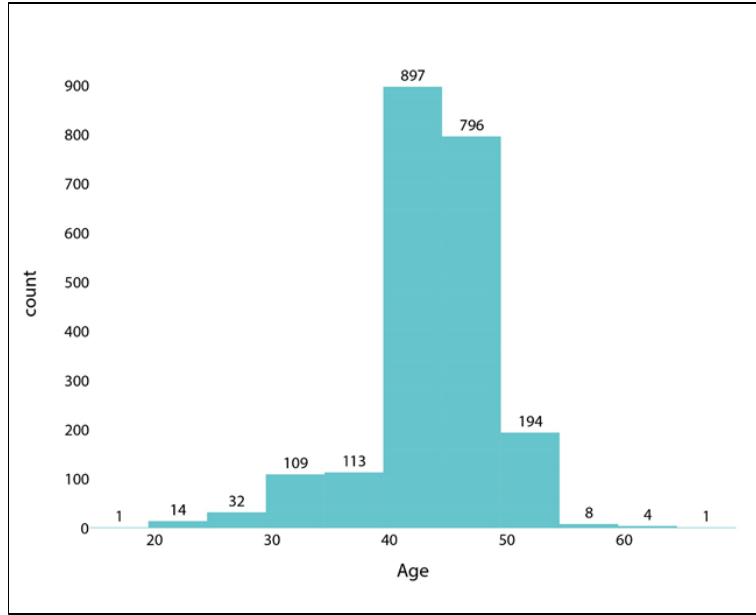
Figure 8. Distribution of confirmed cases where the Age is over 15.